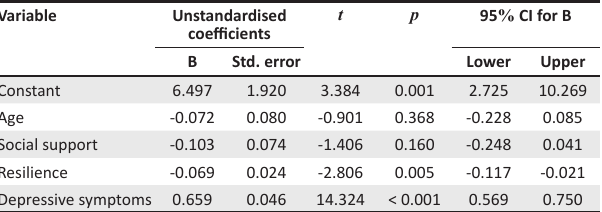
TABLE 8: Predictors of depressive symptoms.